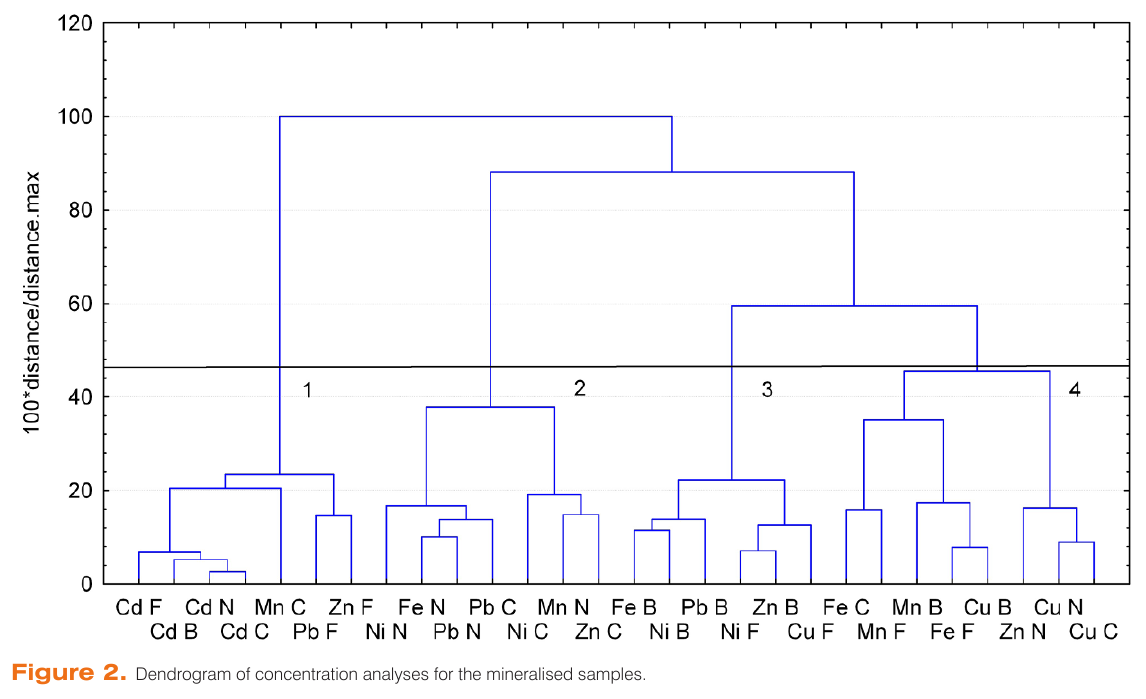
Figure 2. Dendrogram of concentration analyses for the mineralised samples.